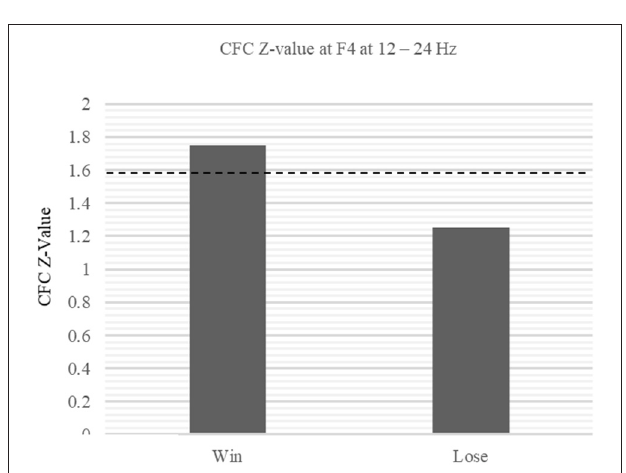
FIGURE 8 | Within-electrode comparison of CFC Z -values between win and lose trials at F4. The Z -values of the CFC at F4 exceeded the threshold during win trial (Win: Z = 1.75, p < 0.05, Lose: Z = 1.25, p > 0.05 at